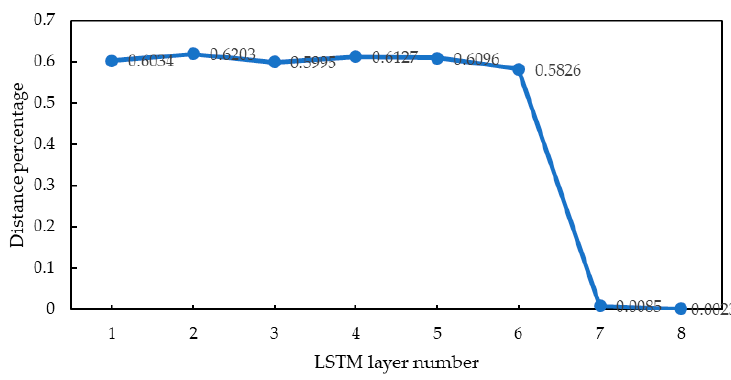
Figure 9. The distance percentage of different LSTM layer number.